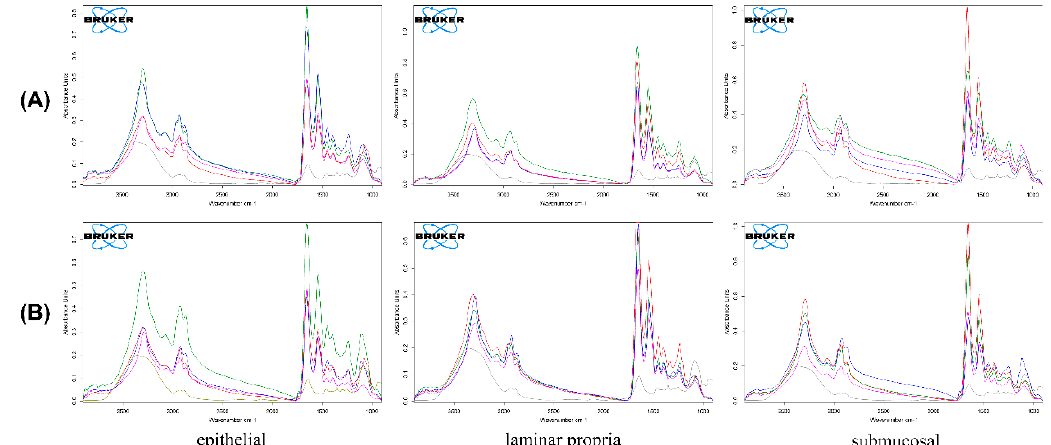
Figure 8. FPA IR of the epithelial, lamina propria, and submucosa layer of the microtome cross- sectioned barrier membrane as fluocinolone acetonide powder (grey line), non-exposure esophagus (red line), and the esophagus exposed to FPM7 ( A ) and FPM8 ( B ) for 5 min (blue line), 15 min (pink line) and 30 min (green line).